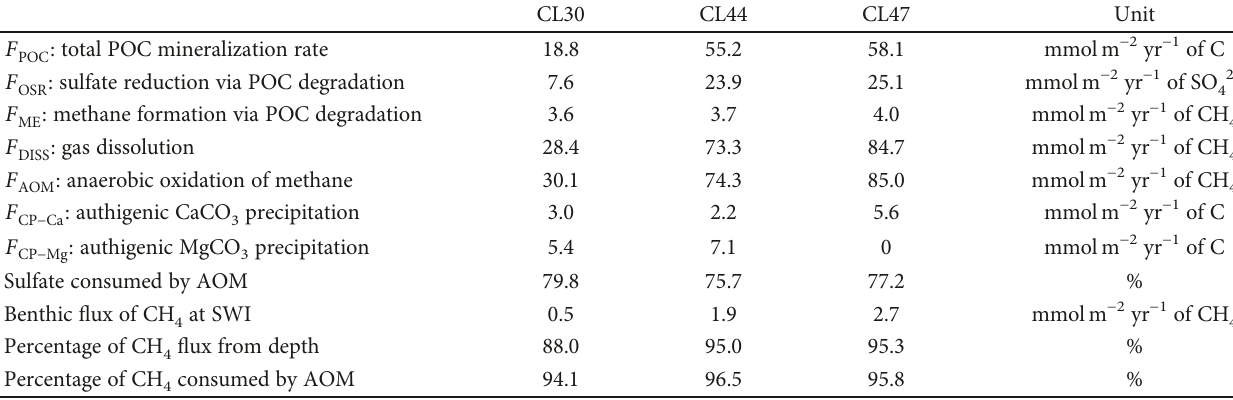
Table 4: Depth-integrated simulated turnover rates and benthic methane fl uxes based on the steady-state modeling.